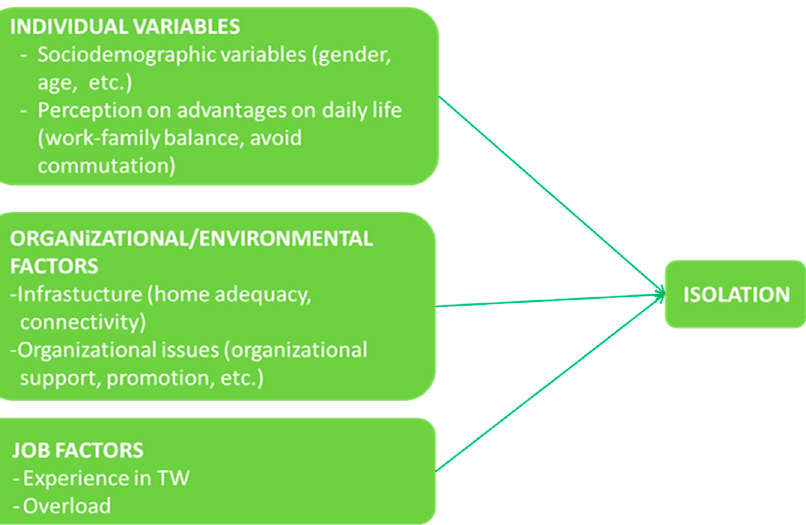
Figure 2. Framework used to explain perceived isolation because of working from home.